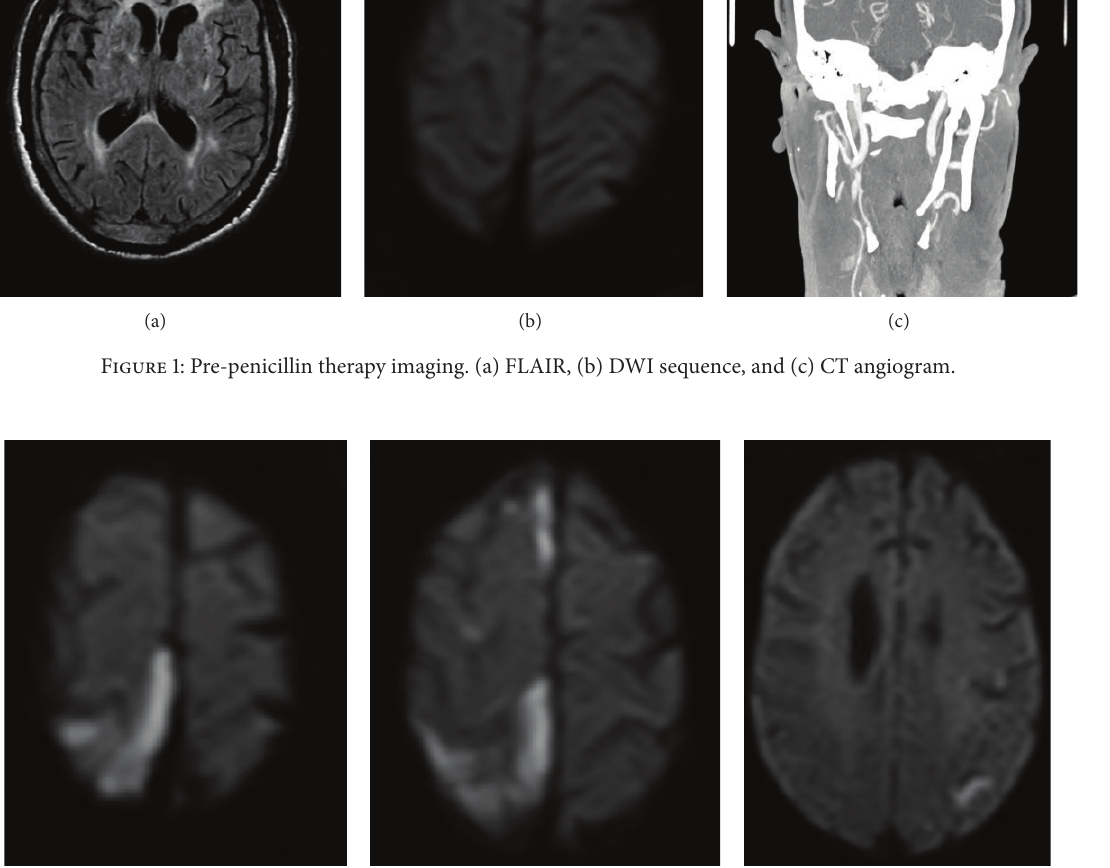
Figure 2: Diffusion sequence immediately after symptom